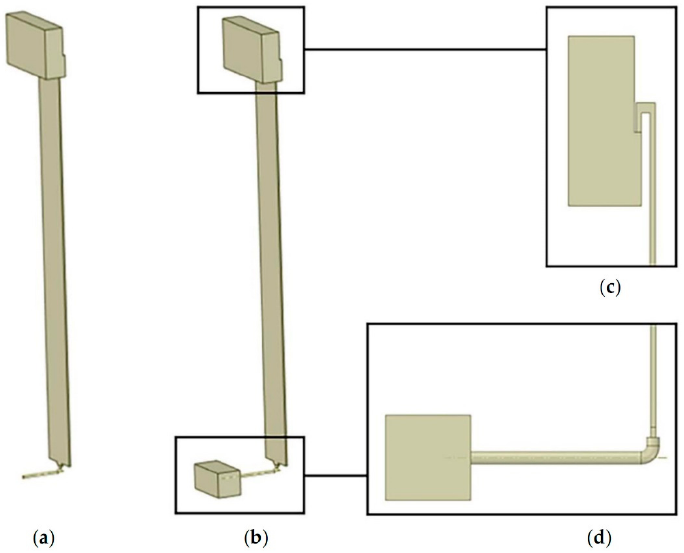
Figure 3. Model geometry for forced ( a ) and natural ( b ) ventilation. Details ( c , d )show respectively the inlet and the outlet domain.